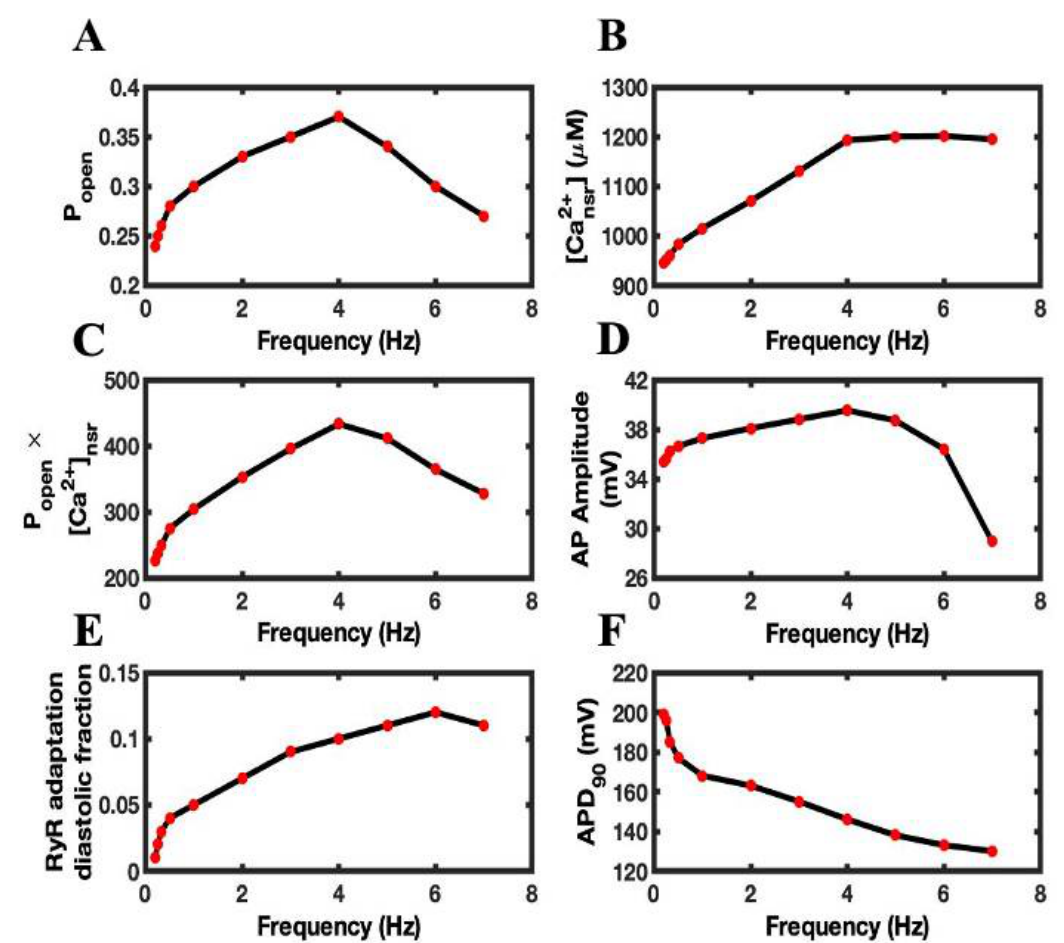
Figure 4. The FFR is determined by Ca 2+ transient in the intracellular chambers of a myocyte. ( A ) RyR2 open probability (P open ). ( B ) The network SR Ca 2+ concentration ([Ca 2+ ] nsr ). ( C ) The peak Ca 2+ release can be approximated by (P open × [Ca 2+ ] nsr ). ( D ) Action potential amplitude. ( E ) The adaptation of RyR2 during the diastolic phase. ( F ) Action potential duration (APD).